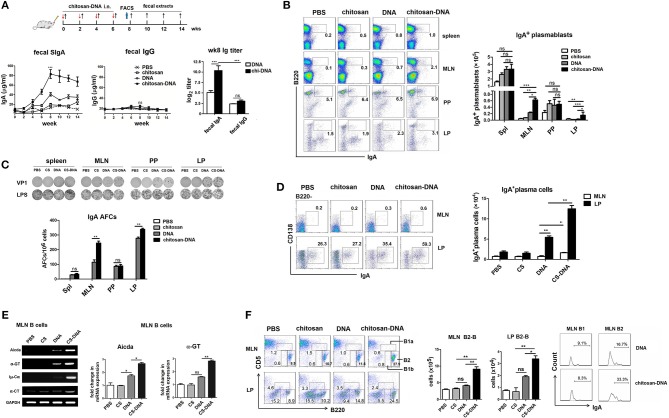
Intranasal immunization with chitosan-formulated DNA enhances specific IgA induction in the gut and B cell IgA CSR in the MLN. (A) Mice were immunized intranasally with chitosan, DNA (pcDNA3-VP1, 50 μg) or chitosan-DNA biweekly for 4 times. VP1-specific IgA in fecal extracts was measured by ELISA at indicated time points. (B) Representative flow cytometry plots (left) and frequency (right) of B220+IgA+ plasmablasts from spleens, MLNs, PPs, and LPs of wk8-chitosan-DNA-immunized mice. Data represent mean ± SEM for six individual mice. Data in A and B is representative of three independent experiments. ***P < 0.001; **p < 0.01; *P < 0.05; ns, not significant. (C) Representative examples of ELISPOT results from wells coated with VP1 peptides for enumeration of VP1-specific IgA antibody-forming cells (AFCs, plasmablasts) in spleen, MLN, PP, and LP of wk8-immunized mice. Experiments were independently repeated three times (n = 6). Numbers of AFCs with mean values ±SEM are shown. **p < 0.01; ns, not significant. (D) IgA+ plasma cells, defined as B220−CD138+IgA+, within the MLN and LP were ensured by flow cytometry, Representative plots were previously gated on B220− cells and frequencies of IgA+ plasma cells in MLN and LP with mean values ± SEM were shown (n = 6). **p < 0.01; *P < 0.05. (E) Representative semi-quantitative (left) or quantitative (right) RT-PCR on sorted B cells from wk8-chitosan-DNA-immunized MLNs for expression of indicated transcripts (Aicda, α-GT, Iμ-Cα, and α-CT). Relative expression of Aicda and α-GT mRNA are displayed as the fold change of respective transcript expression over the expression by Gapdh. Data present mean ± SEM of three independent experiments (n = 6). **P < 0.01; *P < 0.05; ns, not significant. (F) MLN B cells were subdivided into B1a (B220loCD5lo), B1b (B220loCD5neg), and B2-B (B220hiCD5neg) cells according to B220 and CD5 expression. Bar graph represents the absolute number of B2-B cells. Histograms represent expression of mIgA by MLN B1 and B2-B cells after chitosan-DNA immunization. Data present mean ± SEM of three independent experiments (n = 6). **P < 0.01; *P < 0.05.